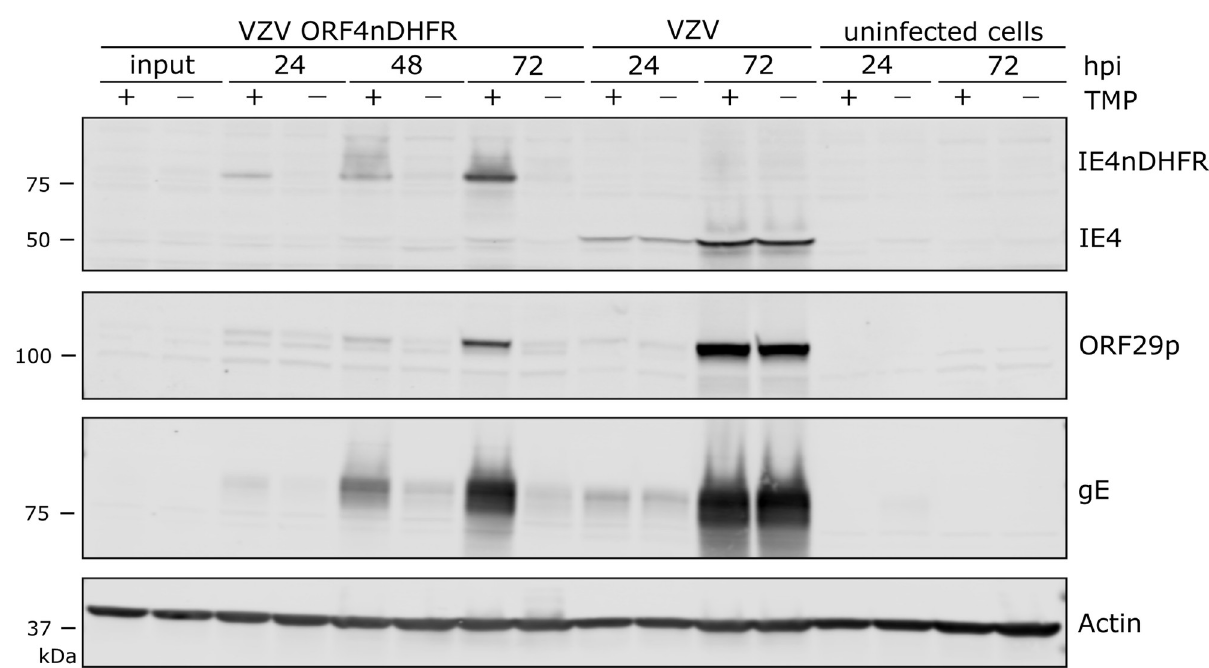
Fig 4. VZV IE4 is regulated by DHFR degron domain fused to amino-terminus. VZV ORF4nDHFR was analyzed in a manner similar to that detailed for VZV ORF9cDHFR in the image and legend for Fig 3, with the exception that additional proteins were identified using antibodies to VZV gE and cellular protein actin. Proteins were from samples grown under TMP permissive (+) and nonpermissive (-) conditions and compared to wild- type pOka infections and uninfected cell equivalents. The blots are scanned in linear range and are representative of two identical experiments.